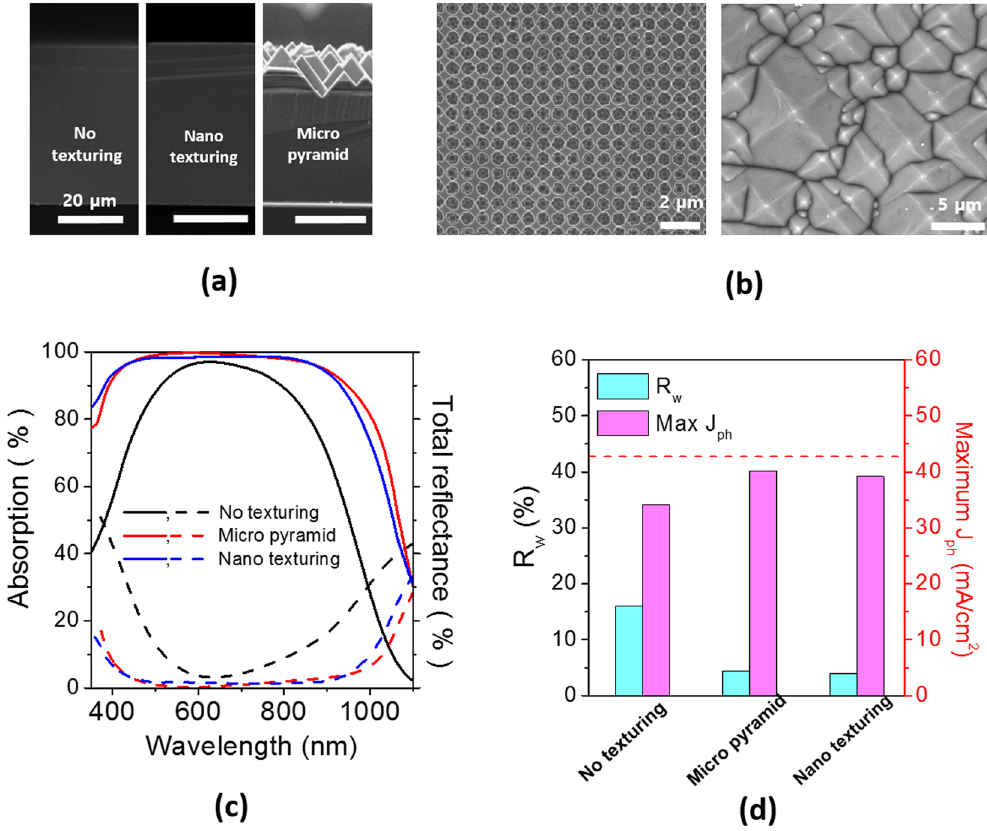
Figure 7. ( a ) Cross-sectional SEM images of the planar, nanohole arrays and micro pyramids. All the scale bars are 20 μ m. ( b ) Top-view SEM images of the nanohole arrays and micro pyramids. ( c ) Total absorption and reflectance of thin wafers of a 48 μ m thickness with different surface texturing: no texturing, micro pyramids, nanohole arrays. ( d ) Weighted reflectances and maximum photocurrents of the thin Si wafers with different texturing and calculated maximum photocurrents with assuming there is no photon-to-electricity conversion